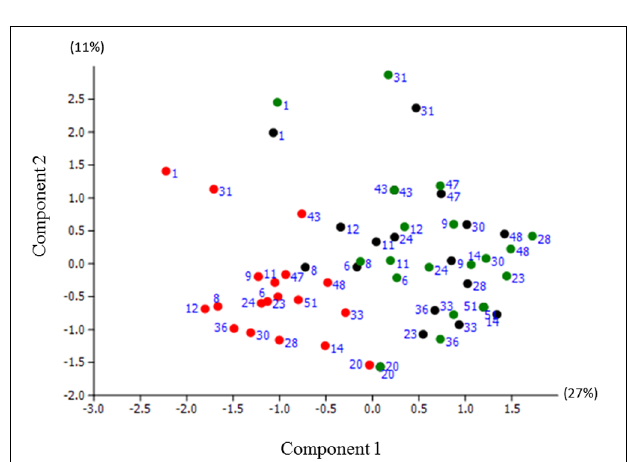
proportions of reads of the respective genera between the post-experimental and the other two visits ( p < 0 . 05, Wilcoxon signed ranks test, after Bonferroni correction for multiple comparisons). N = 19.